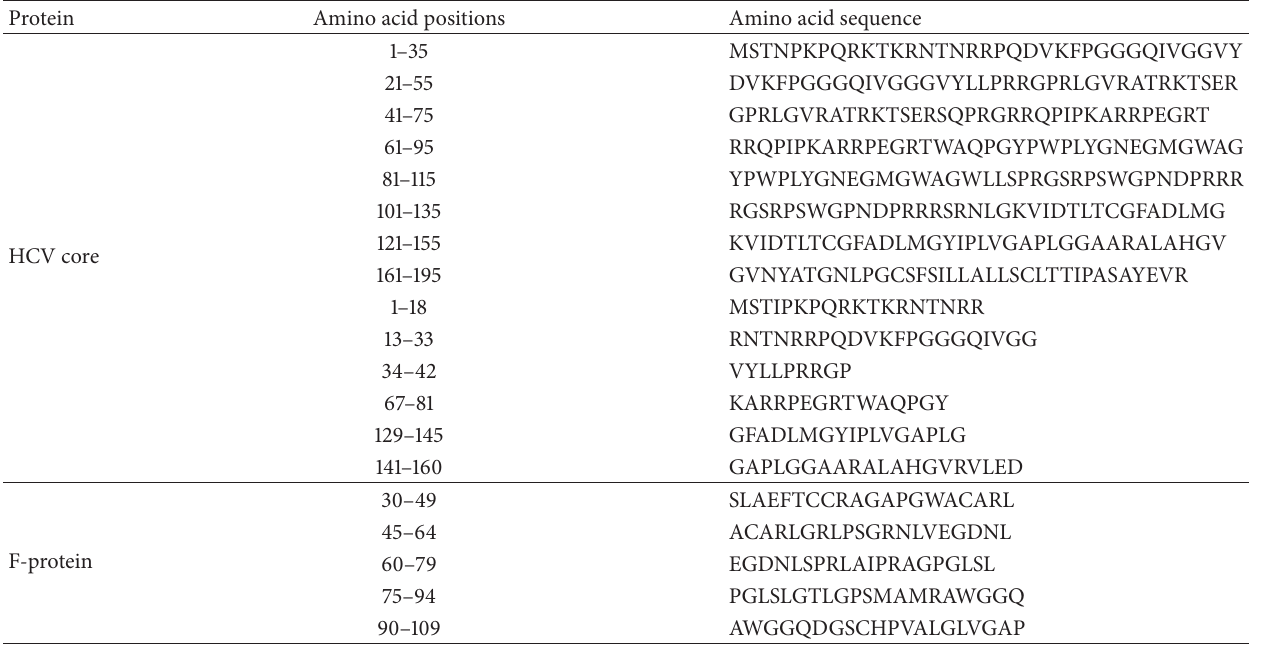
Table 1: A panel of overlapping peptides derived from HCV core and F-protein used in the tests of humoral and cellular immune response. First and last amino acid position are given according to HCV AD78 isolate genotype 1b (GenBank accession number AJ132996 [30,